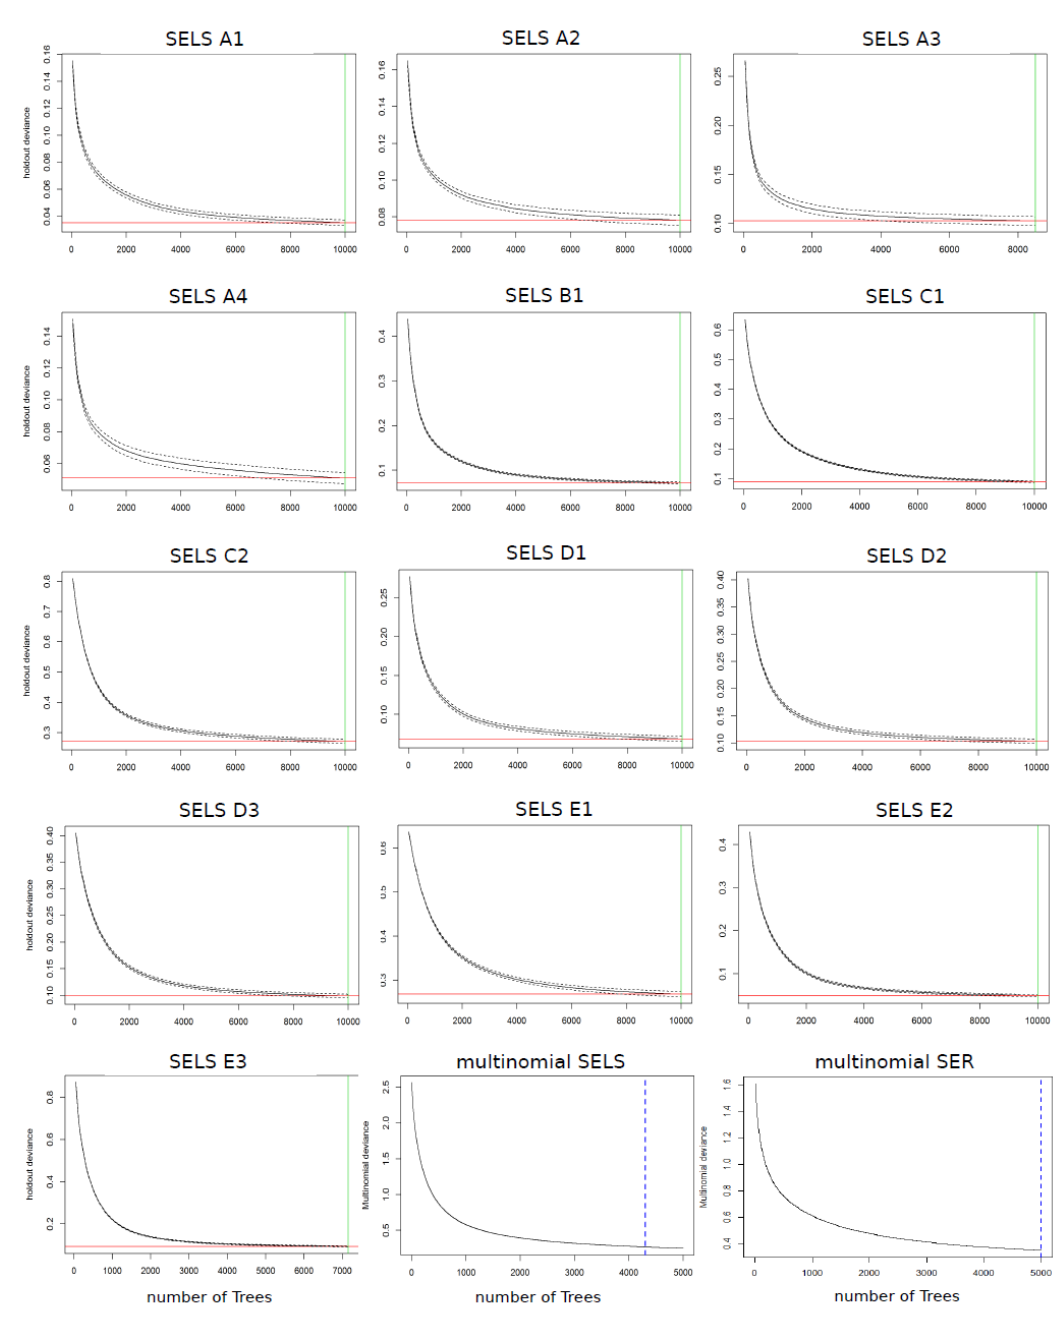
Figure A1.6 . Holdout deviance along the iteration of the BRTs for the individual binomial models (SELS A1 to SELS E3) and the multinomial SELS and SER